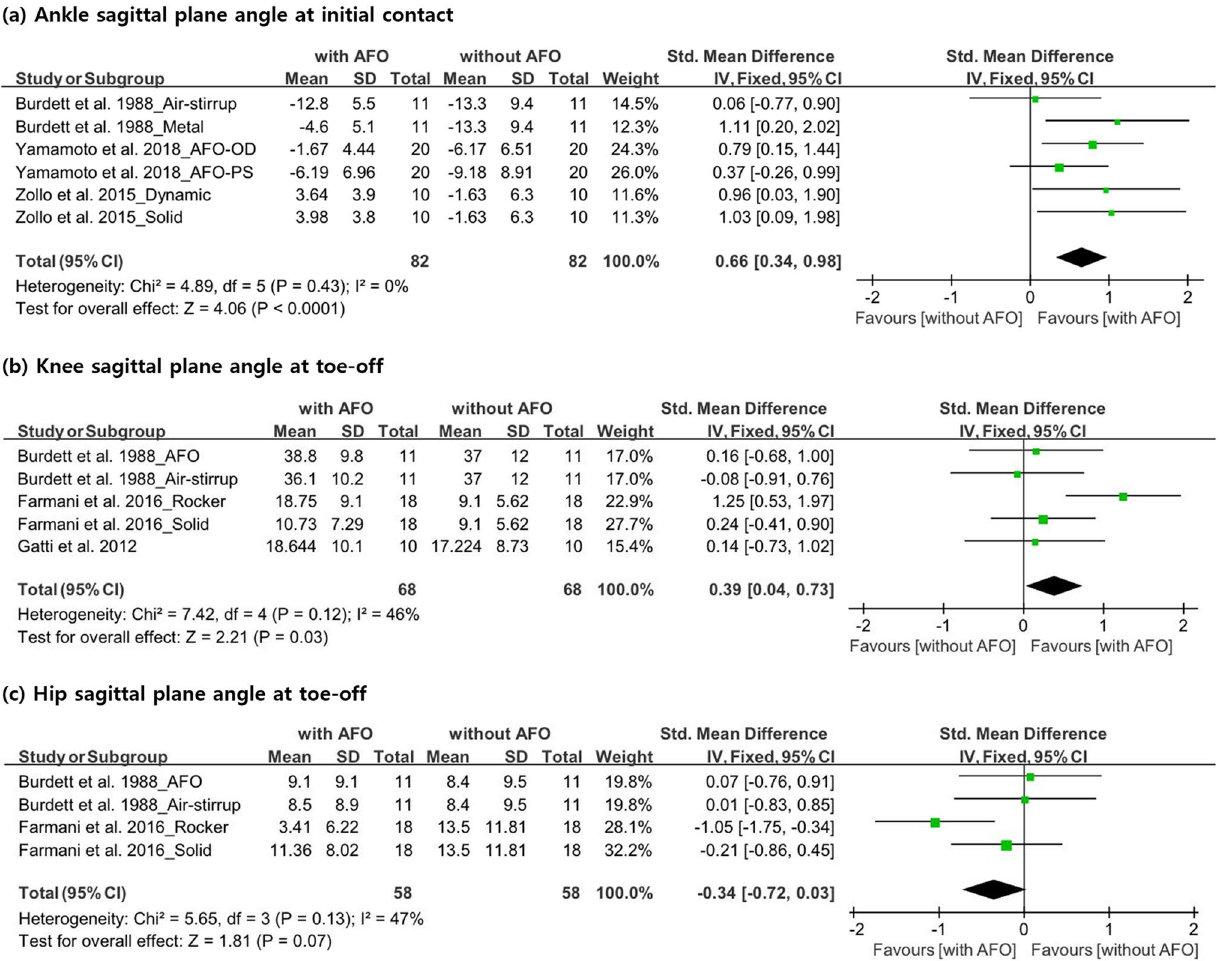
Figure 4. Forest plot showing the results of ( a ) ankle sagittal plane angle at initial contact, ( b ) knee sagittal plane angle at toe-off, and ( c ) hip sagittal plane angle at toe-off with or without ankle–foot orthosis